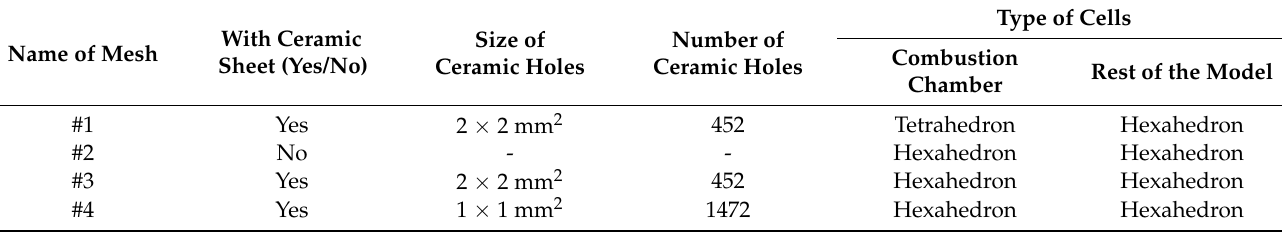
Table 1. Four types of the meshes used in the